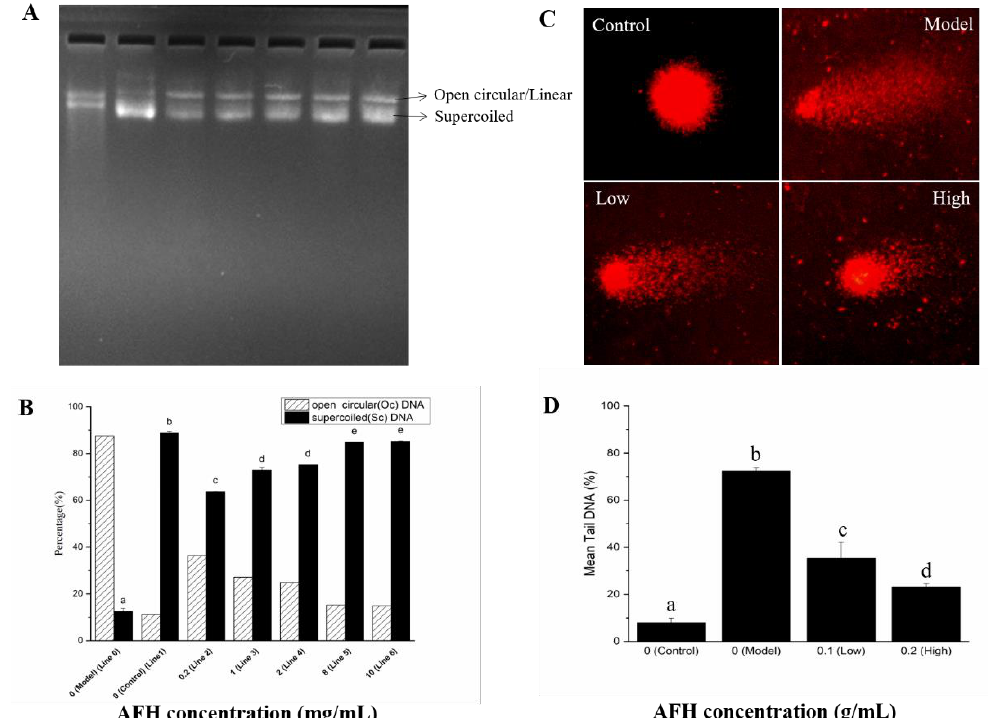
Figure 5. Protective effects of AFH on hydroxyl radical-mediated pBR 322 DNA strand breaks. ( A ): Gel electrophoresis assay. Line 0, 0.5 µg pBR 322 DNA + 1 µL of 1% H 2 O 2 + 1 µL of 1.0 mM FeSO 4 (DNA damage model group). Line1, only 0.5 µg pBR 322 DNA (normal DNA control group). Line 2–6, 0.5 µg pBR 322 DNA + 1 µL of 1% H 2 O 2 + 1 µL of 1.0 mM FeSO 4 + 4 µL 0.2 mg/mL, 1 mg/mL, 2 mg/mL, 8 mg/mL, and 10 mg/mL AFH, respectively. ( B ): Densitonetric analysis of supercoiled (SC) and open circular (OC) plasmid DNA of the gel electrophoresis. ( C ) Comet assay. Control: Normal mouse lymphocytes DNA, Model: Normal mouse lymphocytes DNA incubated with 200 mM H 2 O 2 at 37 °C for 30 min. Low: Normal mouse lymphocytes DNA incubated with 0.1 g/mL AFH solution and 200 mM H 2 O 2 at 37 °C for 30 min. High: Normal mouse lymphocytes DNA incubated with 0.2 g/mL AFH solution and 200 mM H 2 O 2 at 37 °C for 30 min. ( D ) The mean proportion of tail DNA of the comet assay. Different lower case letters correspond to significant differences at p < 0.05.